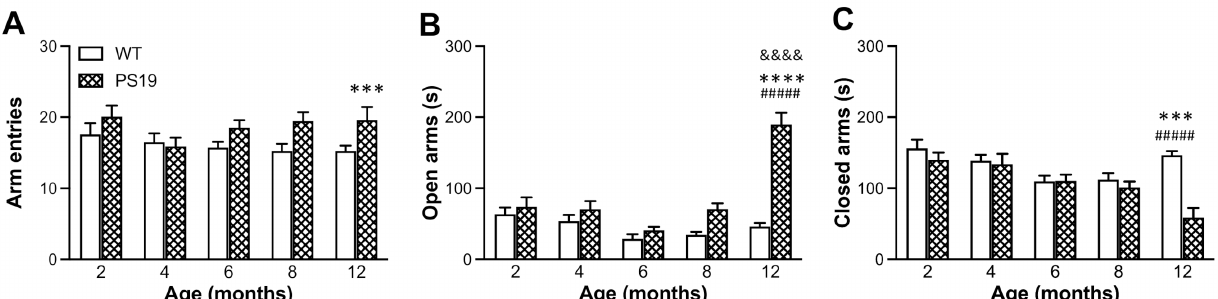
Figure 2. Mean ( ± SEM) total number of arm entries ( A ) and time (s) spent in open arms ( B ) and closed arms ( C ) of male wild-type (WT) and PS19 mice at 2, 4, 6, 8 and 12 months of age in the elevated plus maze test ( n = 11–15/genotype/age). &&&& indicates a significant genotype and age interaction at p < 0.0001. * indicates a significant genotype effect at *** p < 0.001 or **** p < 0.0001. ##### indicates a significant age effect at p <